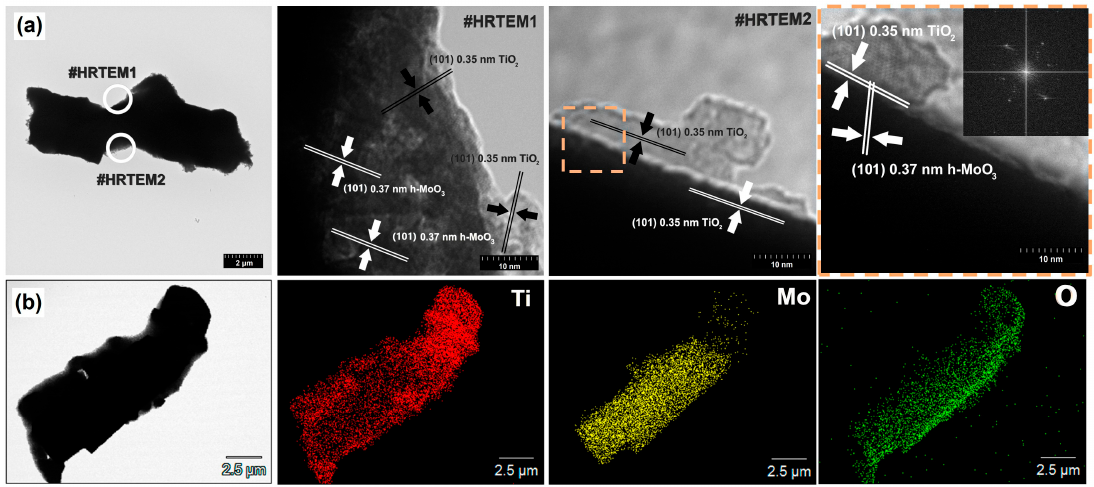
Figure 5. Microstructure of sample Ti8Mo2 in ( a ) HRTEM images and ( b ) EDS mapping with elemental map of titanium, molybdenum and oxygen.